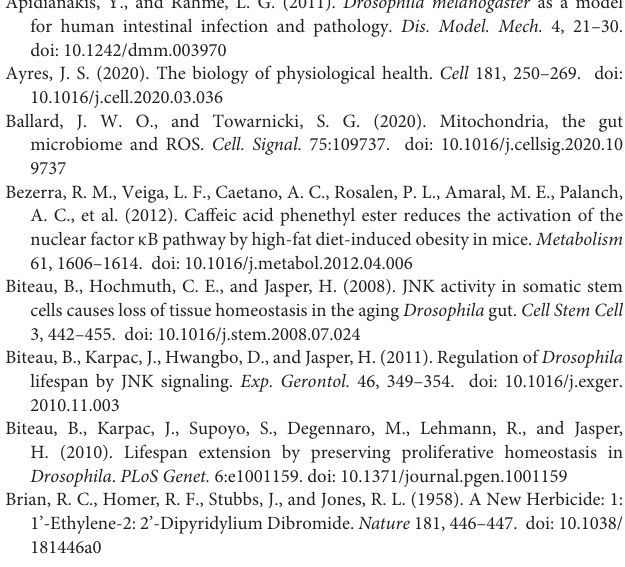
Supplementary Table 1 | Drosophila lines in this study. Supplementary Table 2 | Reagent